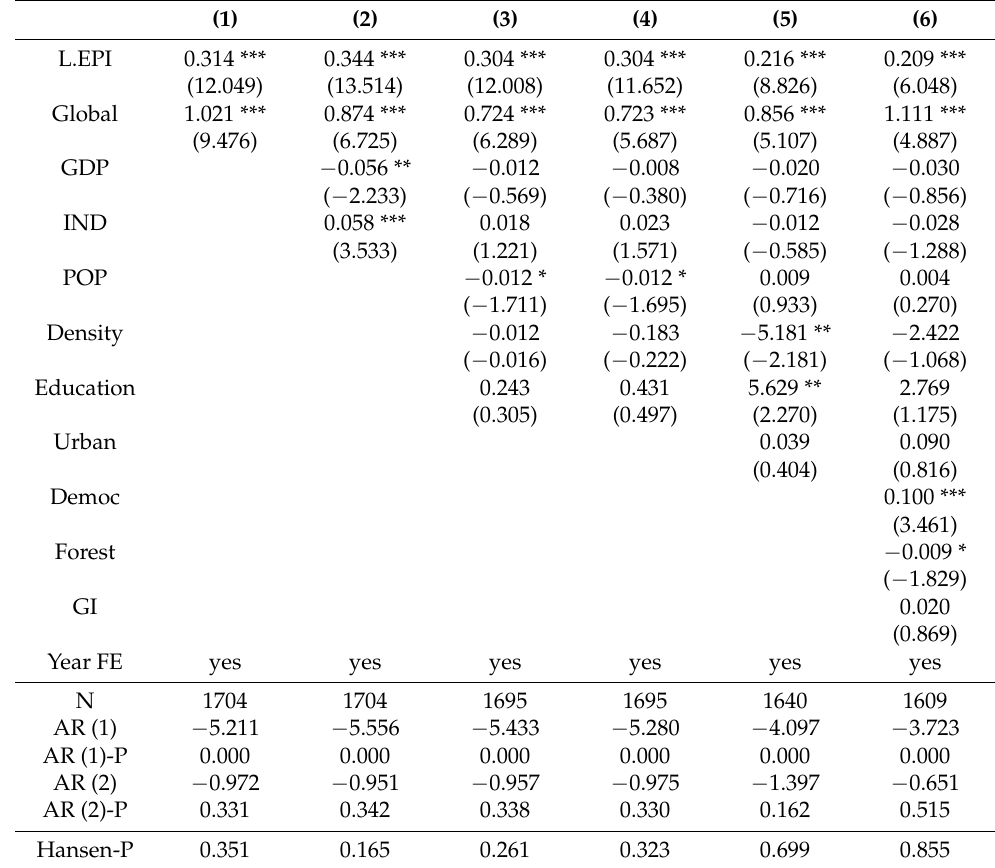
Table 4. Robustness test—DIFF-GMM